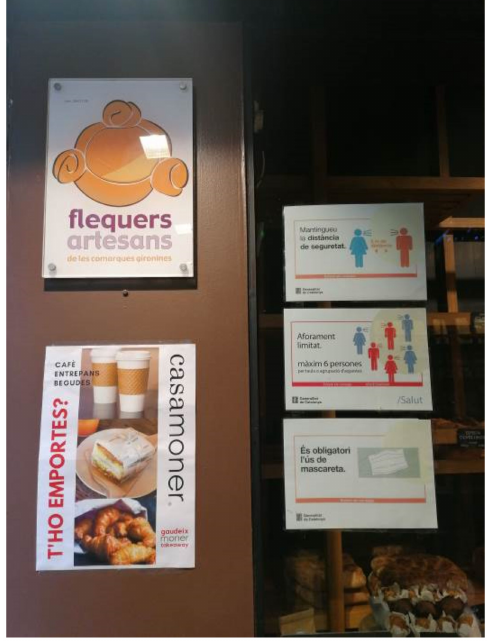
Figure 4. Health and service information at a bakery’s entrance (own